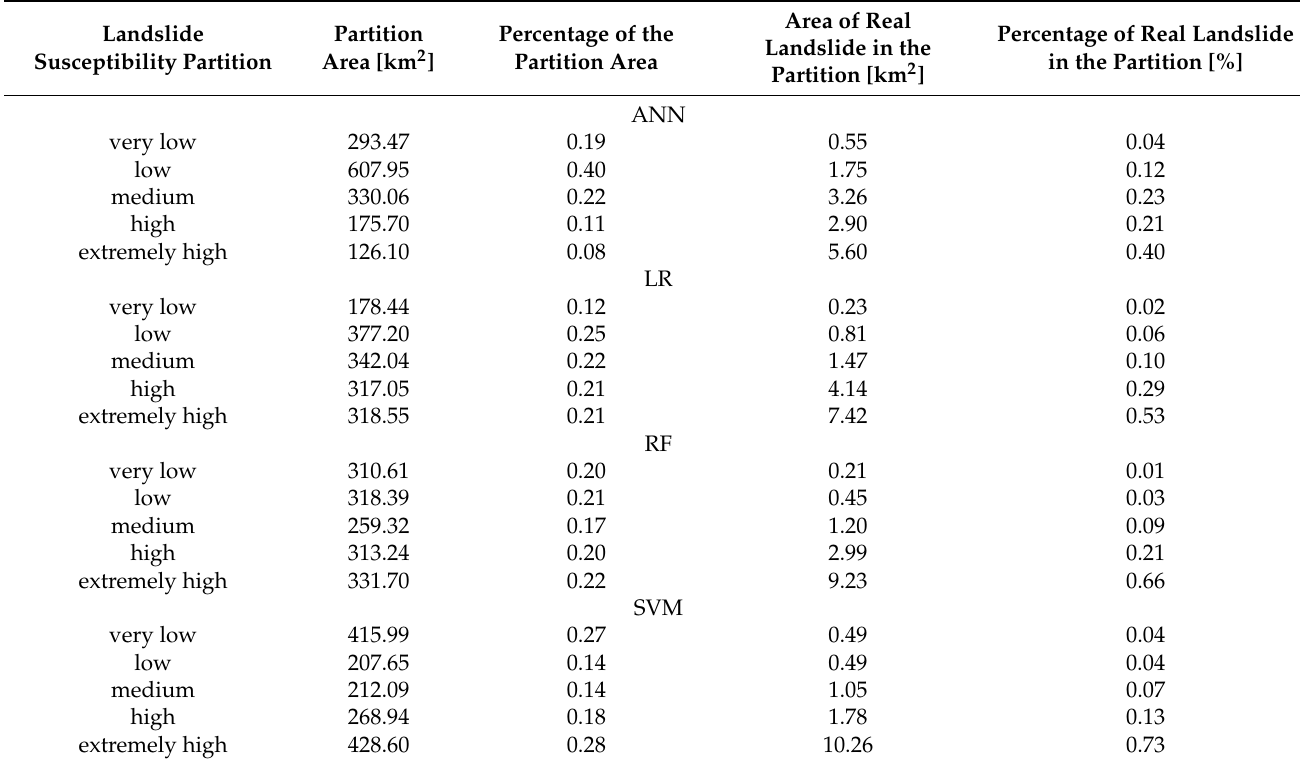
Table 2. The statistical results of superimposing the susceptibility partition with the real landslide